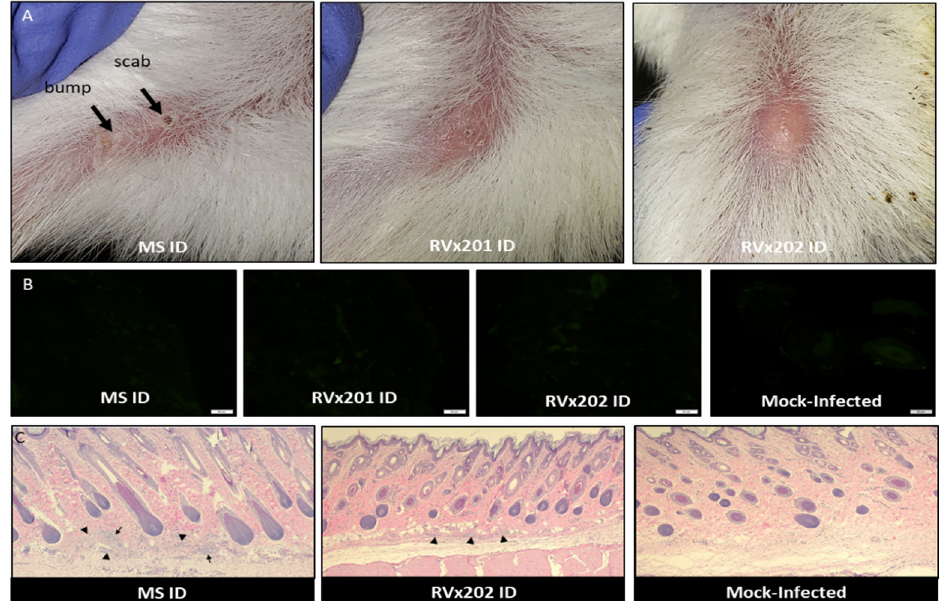
Figure 2. Pathology of lesions at intradermal injection site. ( A ) Representative images of lesions at the injection site following intradermal inoculation with HSV-2 MS (GP48) RVx201 (GP14) and RVx202 (GP27). Guinea pig inoculated with HSV-2 MS developed initial injection site vesicular lesion 6 dpi, which by 10 dpi had progressed to a scab by 10 dpi and a second “bump” appeared. ( B ) Representative images of injection site skin from guinea pigs inoculated ID with HSV-2 MS, RVx201, RVx202, and mock-infected stained for the presence of HSV-2 antigens with a polyclonal antibody. No viral antigen was present in any of the examined injection site skin samples. ( C ) His- topathology examination of injection site skin demonstrated small clusters of leukocytes (arrow- heads), with minimal increase in mature collagenous stroma (fibrosis) associated with minimal chronic inflammation at the dermal/subcutis border in animals inoculated with HSV-2 MS and RVx202 (RVx201 was similar to RVx202). Mock-infected guinea pigs injected with PBS or Vero cell lysate showed no such changes.